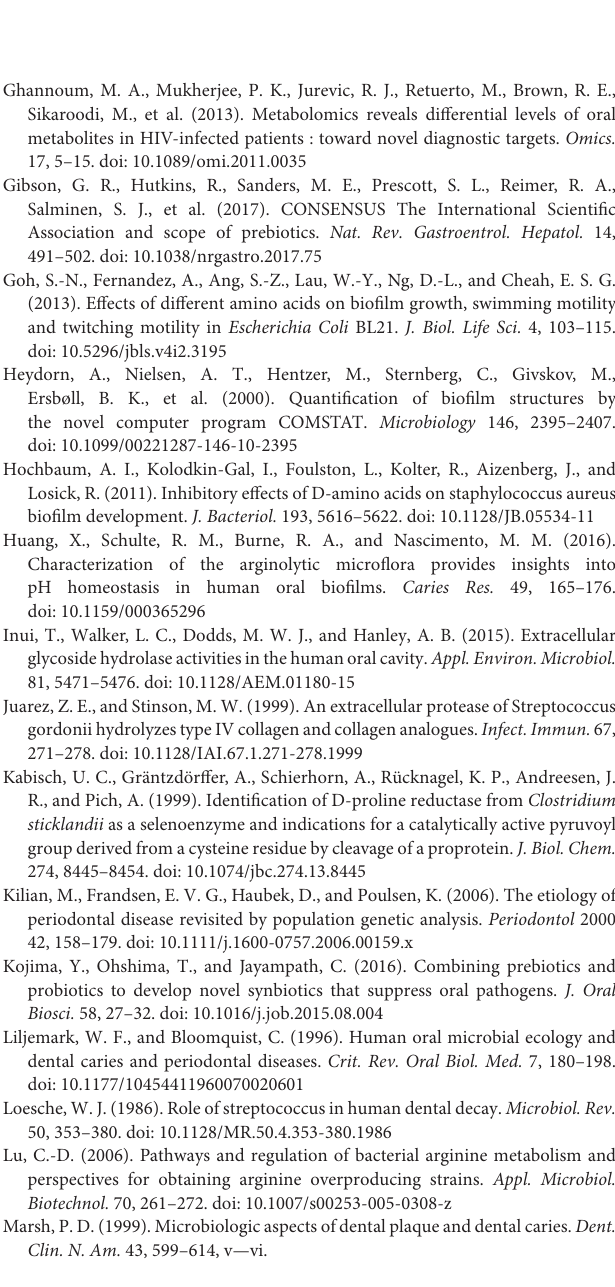
Supplementary Figure 1 | Confocal laser scanning microscopy images of unsupplemented and supplemented biofilms on hydroxyapatite discs stained with SYTO-9 and propidium iodide (x63 magnification, live bacteria are green, dead bacteria are red). Supplementary Figure 2 | Coomassie-stained SDS-PAGE gel for unsupplemented (positive control) biofilms and incubated sterile saliva (negative control) at days 4 and 7, with the sterile saliva standard in wells one to three ( n =